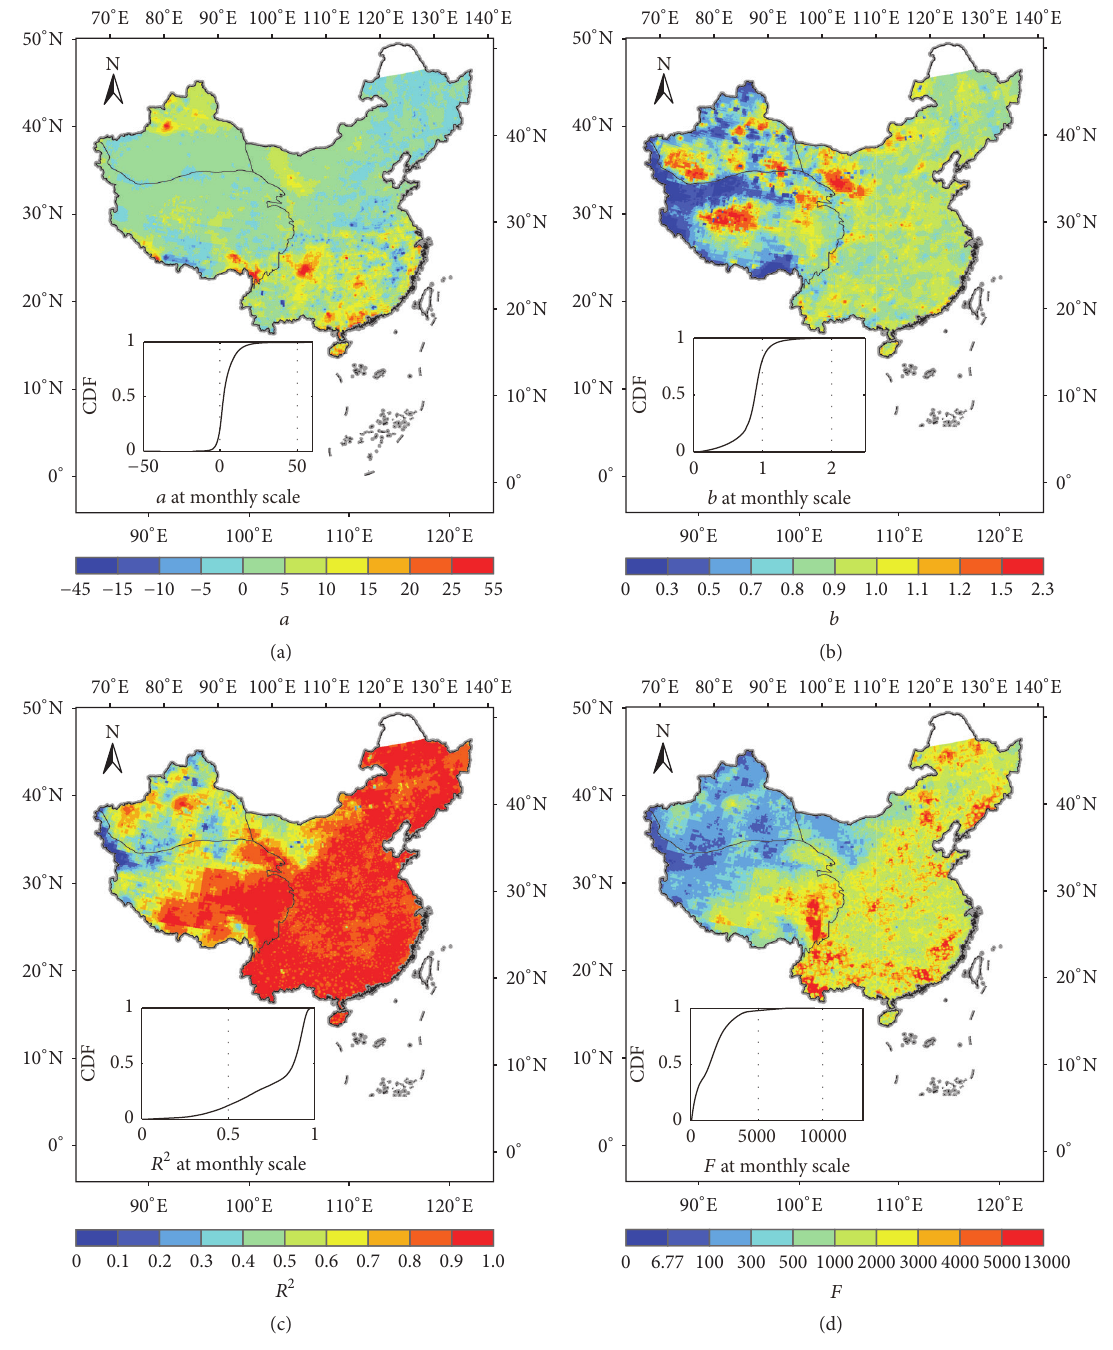
Figure 4: Monthly linear regression model result over China: (a) offset parameter 𝑎 , (b) scale parameter 𝑏 , (c) 𝑅 2 , and (d) 𝐹